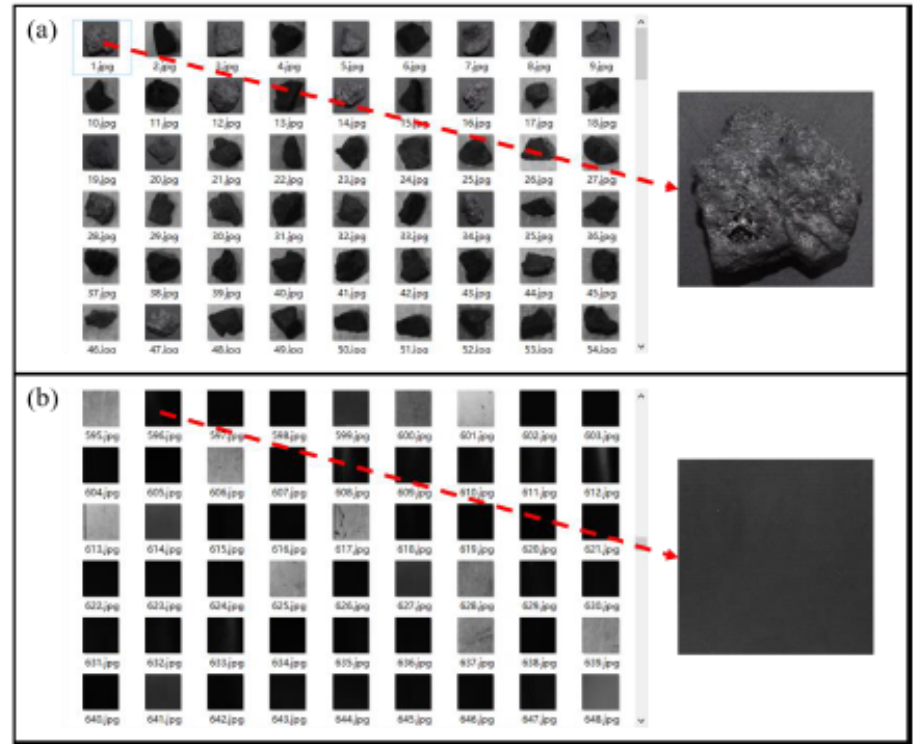
Figure 7. Dataset for HOG + SVM training. ( a ) Positive sample; ( b ) Negative sample.